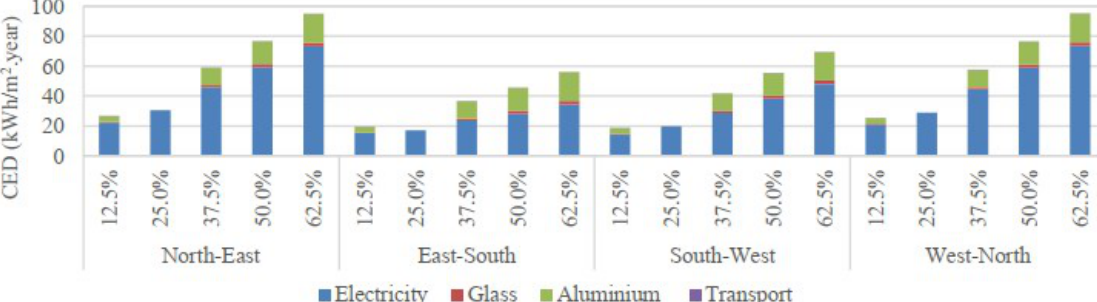
Figure 4. Embodied Energy per m 2 · year – WWR scenarios.